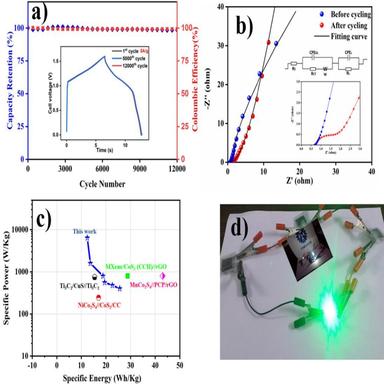
(a) Cycling stability of the hybrid device at 5 A/g, the CD profile at various cycles (inset). (b) EIS plot of the hybrid device before and after cycling, enlarged view of higher frequency region (inset). (c) Ragone plot for the supercapattery (d) Supercapattery device lights up a green LED and a white LED independently (inset). (For interpretation of the references to colour in this figure legend, the reader is referred to the web version of this article.)